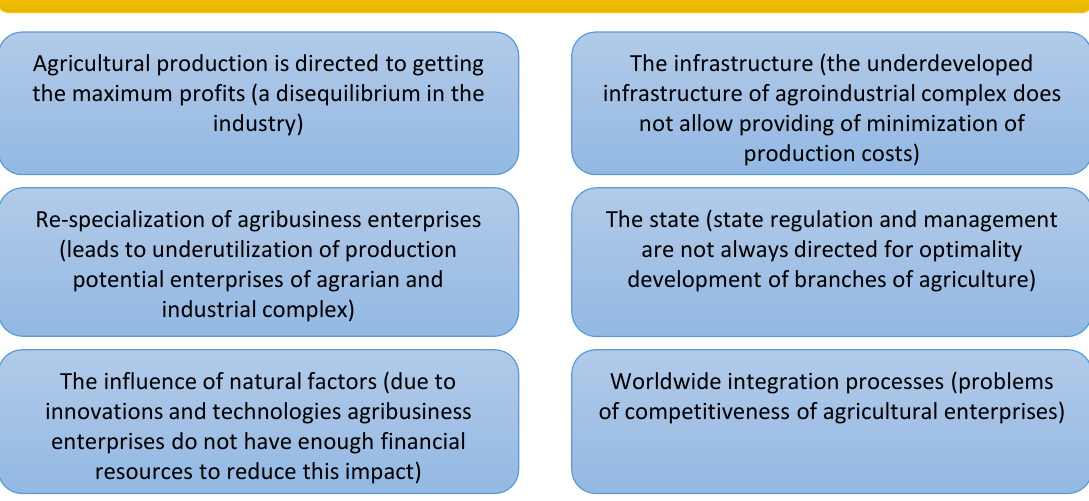
Figure 1. The problems of ensuring sustainable development of the agrarian sector of